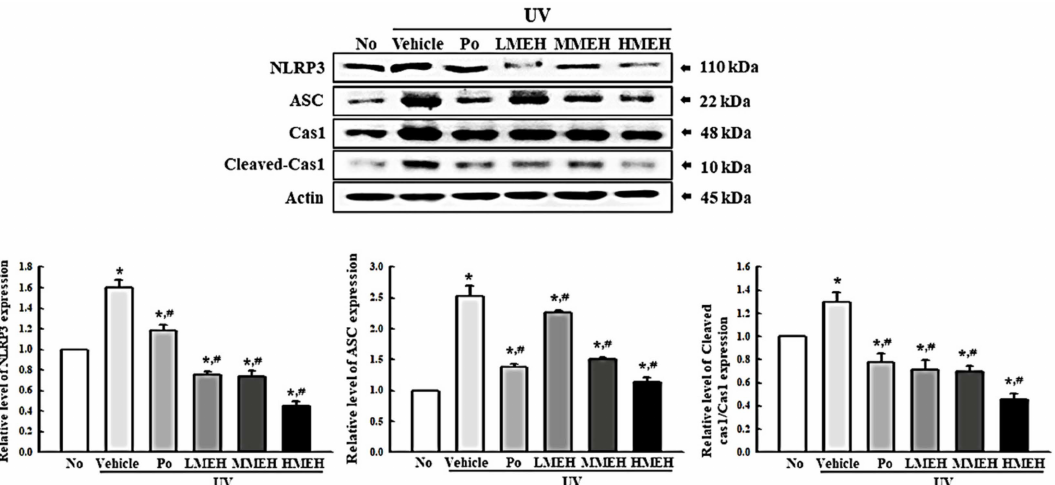
Figure 11. Expression of inflammasome proteins in normal human dermal fibroblasts. Three dishes per group were used to prepare cell lysates. Western blot was performed in triplicate. This experiment was performed for three times and results are the average of all experiments. The data are reported as the means ± SD of triplicate determinations. *, p < 0.05 compared to the untreated group. #, p < 0.05 compared to the UV + Vehicle group. Abbreviations: NLRP3, NLR family pyrin domain containing 3; ASC, Apoptosis-associated speck-like protein; Cas-1, Caspase 1; IgG, Immunoglobulin G; Po, Positive control; MEH, Methanol extract of Hygrophila erecta (Brum. F.)